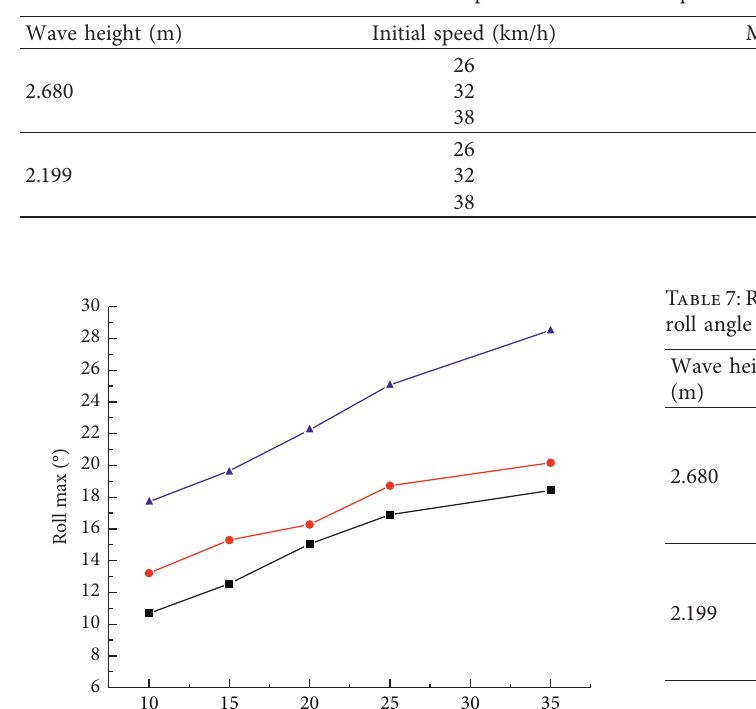
Table 6: Relationship between the initial speed and the maximum roll angle.